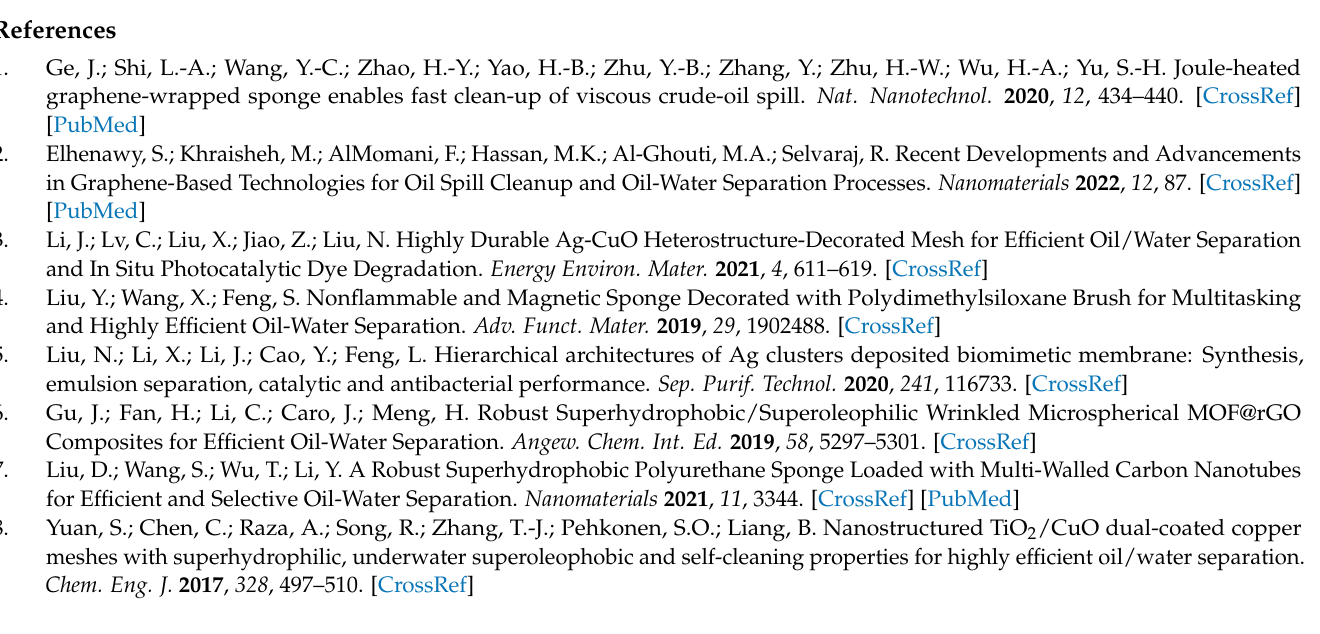
corresponding elemental mapping images of glued SSM. The scale bar is 1 µ m. Figure S2: SEM images of the fabricated meshes at different coating times: (a) 5 min and (b) 1 h. Figure S3: Nitrogen adsorption/desorption isotherm curve of CS powders. Figure S4: SEM images of (a) the pristine SSM and (b) CS-coated SSM without glue pretreatment, insets show the corresponding water CAs. Figure S5: SEM image of CS-coated mesh after ultrasonic wear for 2 h, inset shows the corresponding water CA. Figure S6: Separation process of diesel/water mixture by the CS coated mesh. Figure S7: SEM image of CS coated mesh after being repeatedly utilized for 20 cycles of oil/water separation tests, inset was the corresponding water CA. Video S1: Continuous water droplets from the pipet readily bounced off the surface of CS-coated mesh. Video S2: Removal process of a drop of CCl 4 dyed with Sudan III from water. Video S3: Separation process of the light oil (hexane)/water mixture. Video S4: Separation process of the heavy oil (CCl 4 )/water